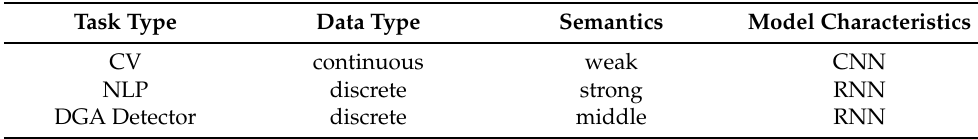
Table 3. Backdoor attack against different